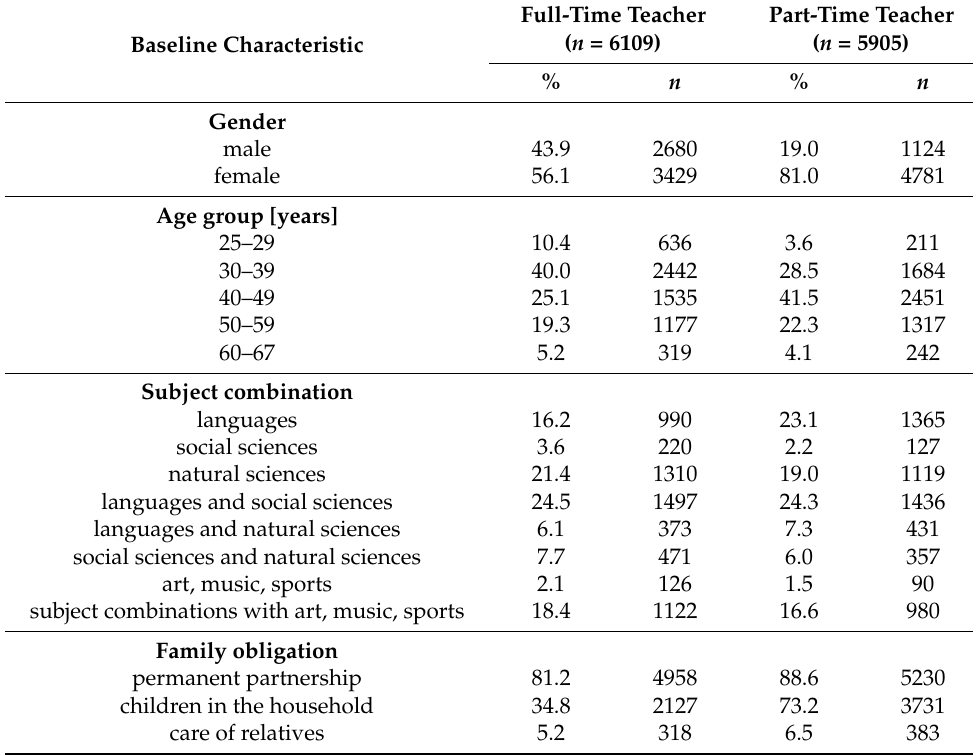
Table 1. Characteristics of the